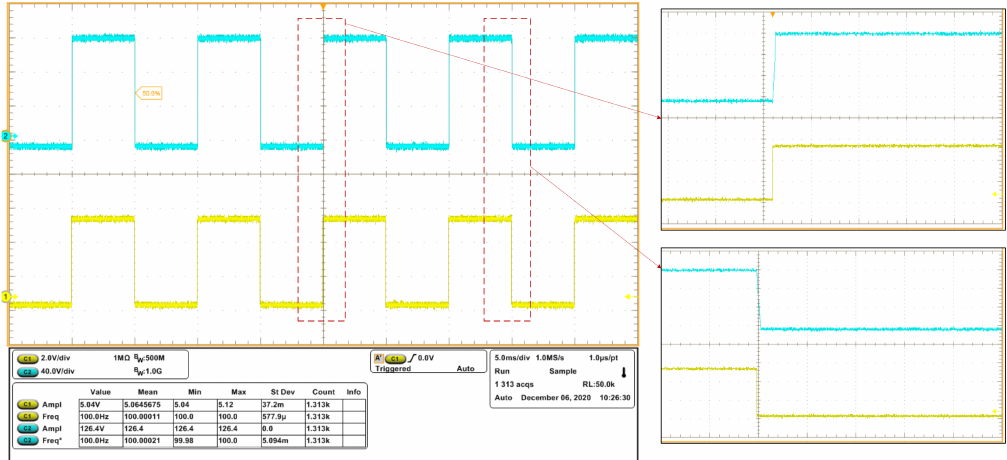
Figure 28. Measured square wave input–output waveforms for the power amplifier using general operational amplifiers. The simulated and measured results of the power amplifier are presented by compari- son, and the two results match each other well. The simulation and the tests demonstrate that the proposed method could well be applied in the design of the power